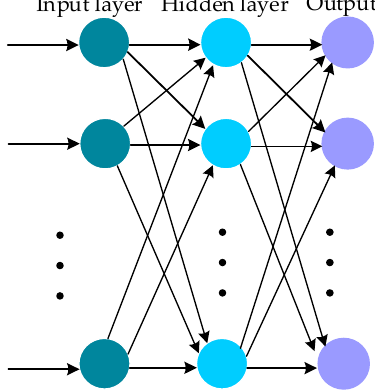
Figure 1. The classical architecture of BP-ANN (back propagation artificial neural network).